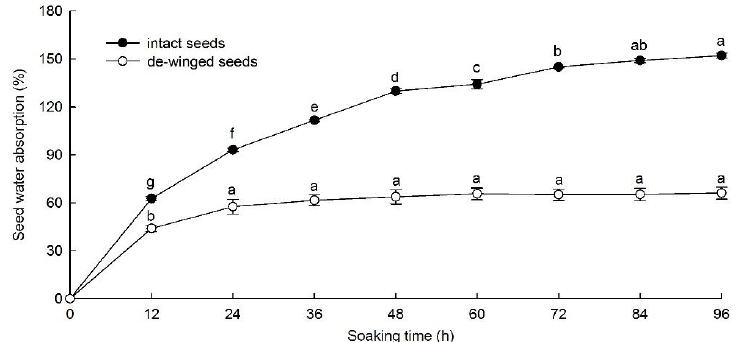
Figure 1. Water absorption (mean ± standard error) of intact and de-winged F. rhynchophylla seeds from 0 to 96 h. Different lowercase letters indicate significant differences between different soaking time for the same treatment showed by Duncan multiple comparison ( p < 0.05).